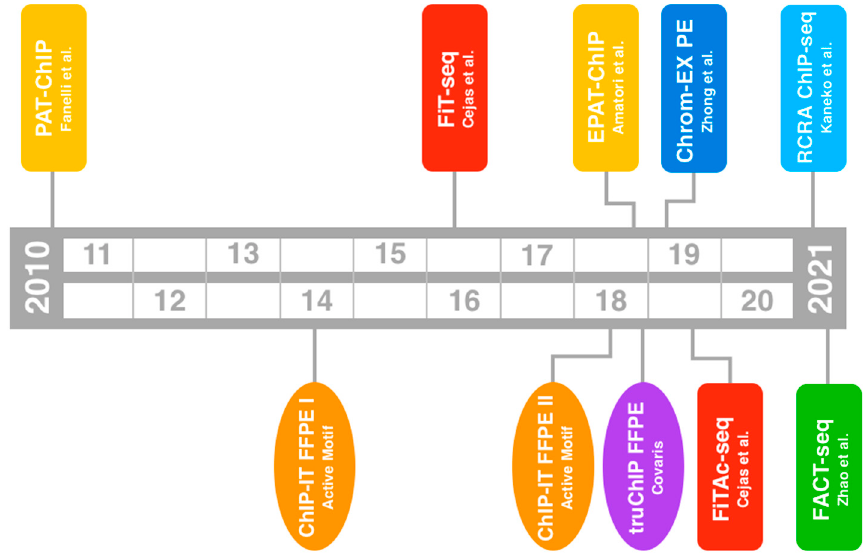
Figure 1. Timeline of the FFPE-ChIP procedures and kits introduced over time. Procedures are in rectangles while kits are in ovals. Specific colors are used for each research group and company.